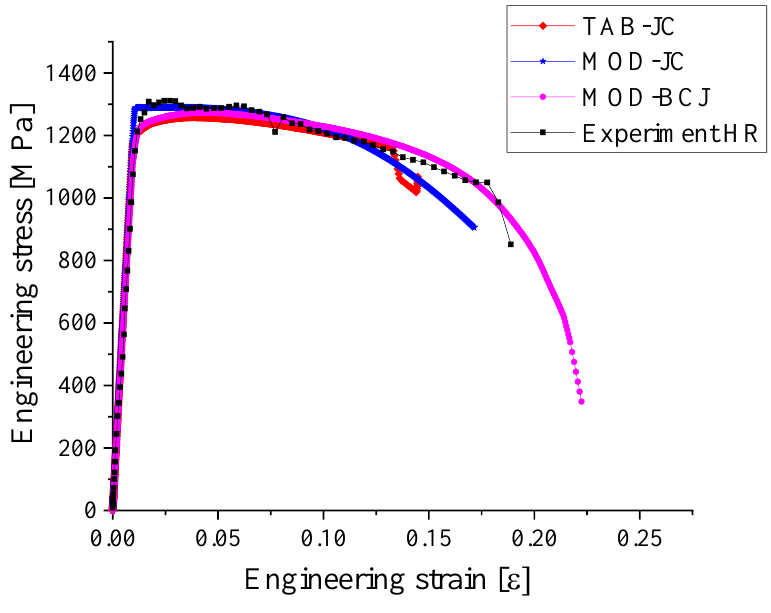
Fig. 5. Comparison of the various numerical models against the high-rate engineering response of Ti-